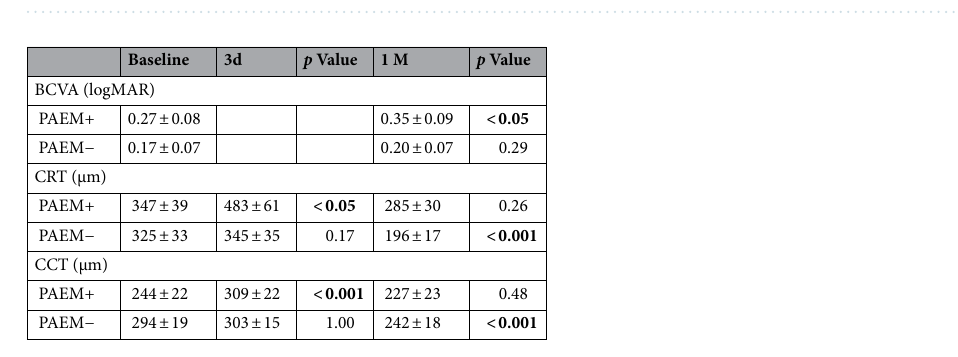
Table 2. Visual and anatomical changes at 3 days and 1 month after PDT compared to baseline. Significant values are in bold.